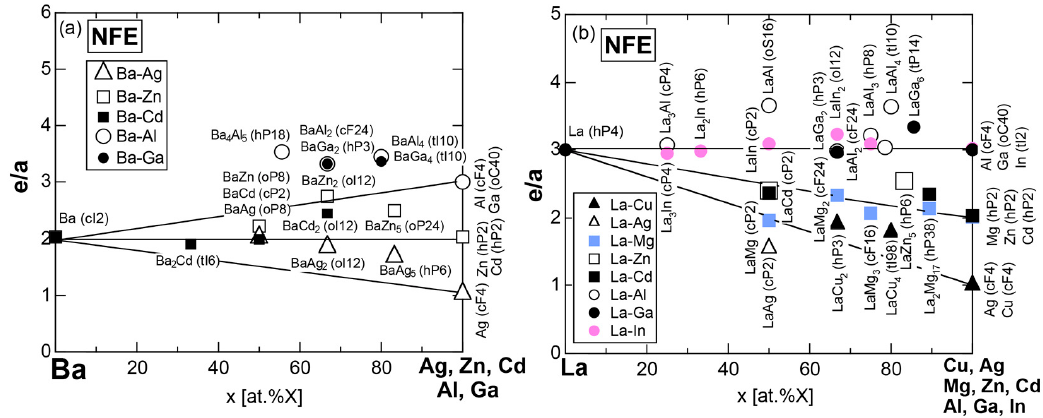
Figure 96. Composition dependence of e/a for intermetallic compounds and pure elements in ( a ) Ba–M (M = Ag, Zn, Cd, Al, Ga) and ( b ) La–M (M = Cu, Ag, Mg, Zn, Cd, Al, Ga, In) alloy systems [37]. The NFE method is employed for elements Ba, La and all the compounds but the local reading method for elements located at 100 at.%M. The linear interpolation lines are drawn by connecting end points of pure elements in the respective alloy systems. Symbols in bracket refer to the Pearson symbol for elements and compounds.